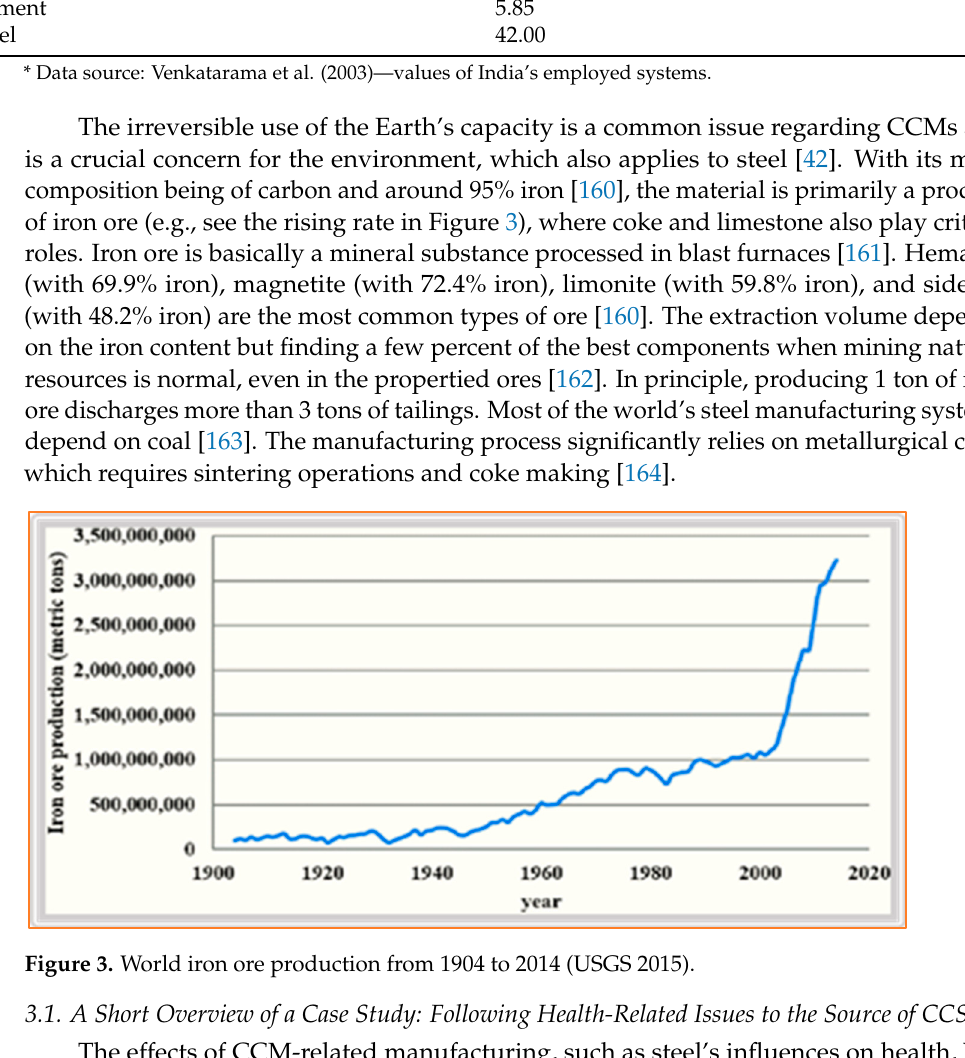
(c) Figure 4. Views of the company: ( a ) TISCO Europe, Ijmuiden; ( b ) Wijk aan Zee view, city view and (c) Wijk aan Zee view, another city view (RTL News, 2 September 2021 and Broekhuijsen, 2021). Hence, TATA Ijmuiden, similar to the entire steel industry [167], continuously en- dangers its employees, who are also occupants of houses in the local neighbourhoods. Awolusi et al. [167] emphasise that steel manufacturing is an unsafe working environ- ment. In the case of TISCO Ijmuiden (TATA), in addition to the hot and uncomfortable operating conditions and other issues [168] for the employees’ WB, the company impacts the environment in various ways (based on local observations in June 2021). Moreover,